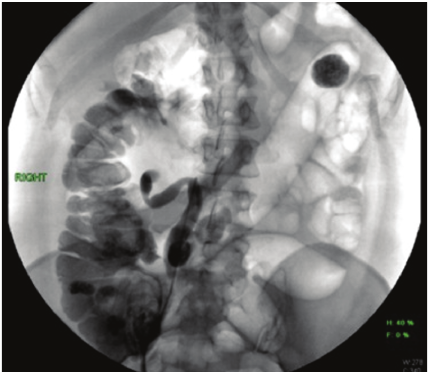
Figure 1: Cystoscopy and retrograde pyelogram demonstrating severe hydroureter.